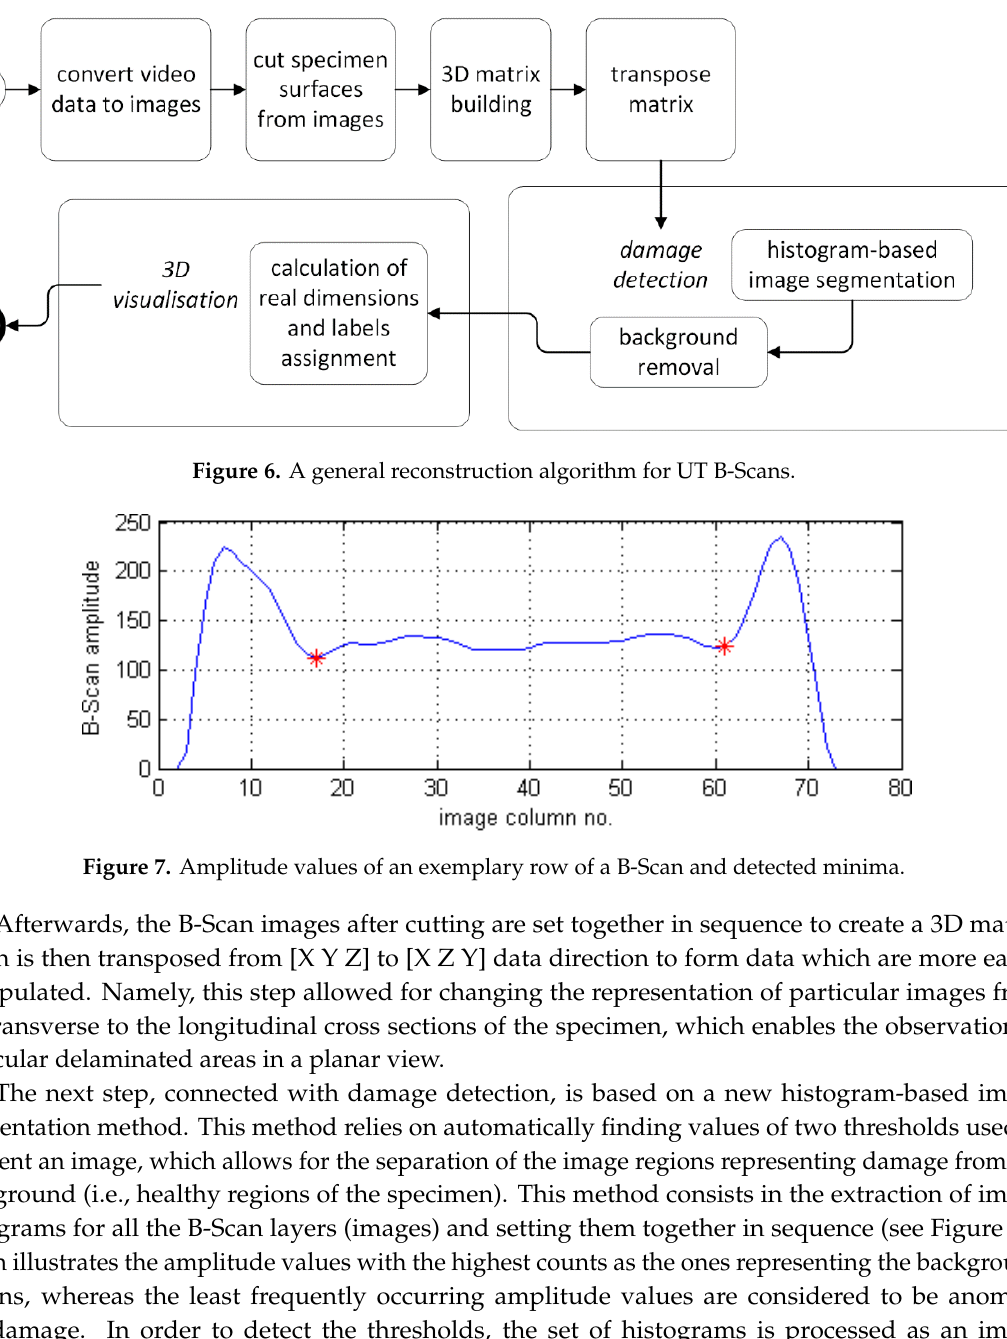
4. Development of Algorithms for Impact Damage Reconstruction and Representative Results